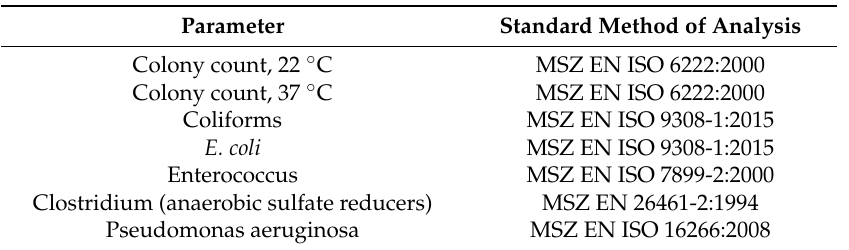
Table 2. Measured microbiological parameters and applied standard